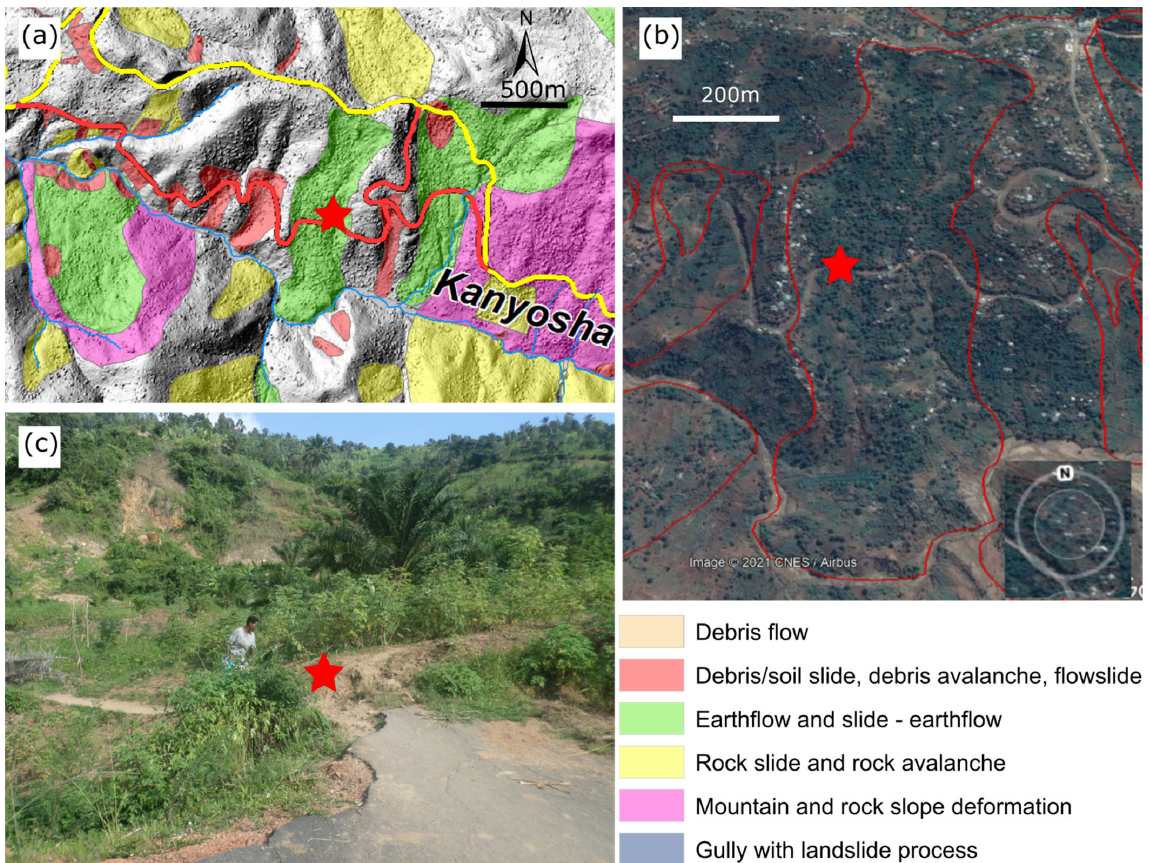
Figure 6. Focus on a landslide impact zone on the national road NR7. ( a ) Location of the NR7 in the Kanyosha watershed with the distribution of the inventoried landslides. The current road is in yellow, the former section is in red. The hillshade is derived from 1-m-resolution DEM built from Pléiades tri-stereo images (Table 1). ( b ) Zoom image of one of the active earthflows (©Google Earth image of 05 August 2018). ( c ) Damaged section of the former road NR7. Photo taken in June 2016 ( − 3.431°, 29.393°).